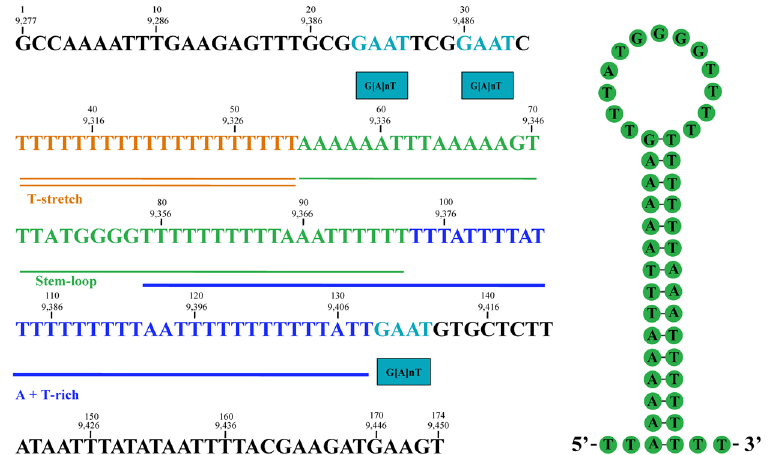
Figure 2. Sequence features in the mitochondrial control region of the grass thrips, Anaphothrips obscurus . T-stretch is shown as double line, stem-loop as thin line, AT-rich sequence as thick line and G(A)nT motifs as boxes with blue color. The secondary structure of stem-loop is shown in the right of the figure. The numbers above sequences in the upper row indicate nucleotide positions starting from the 5 ′ -end of control region; the number in the lower row indicate nucleotide positions starting from the 5 ′ -end of cox1 in the mitochondrial genome.